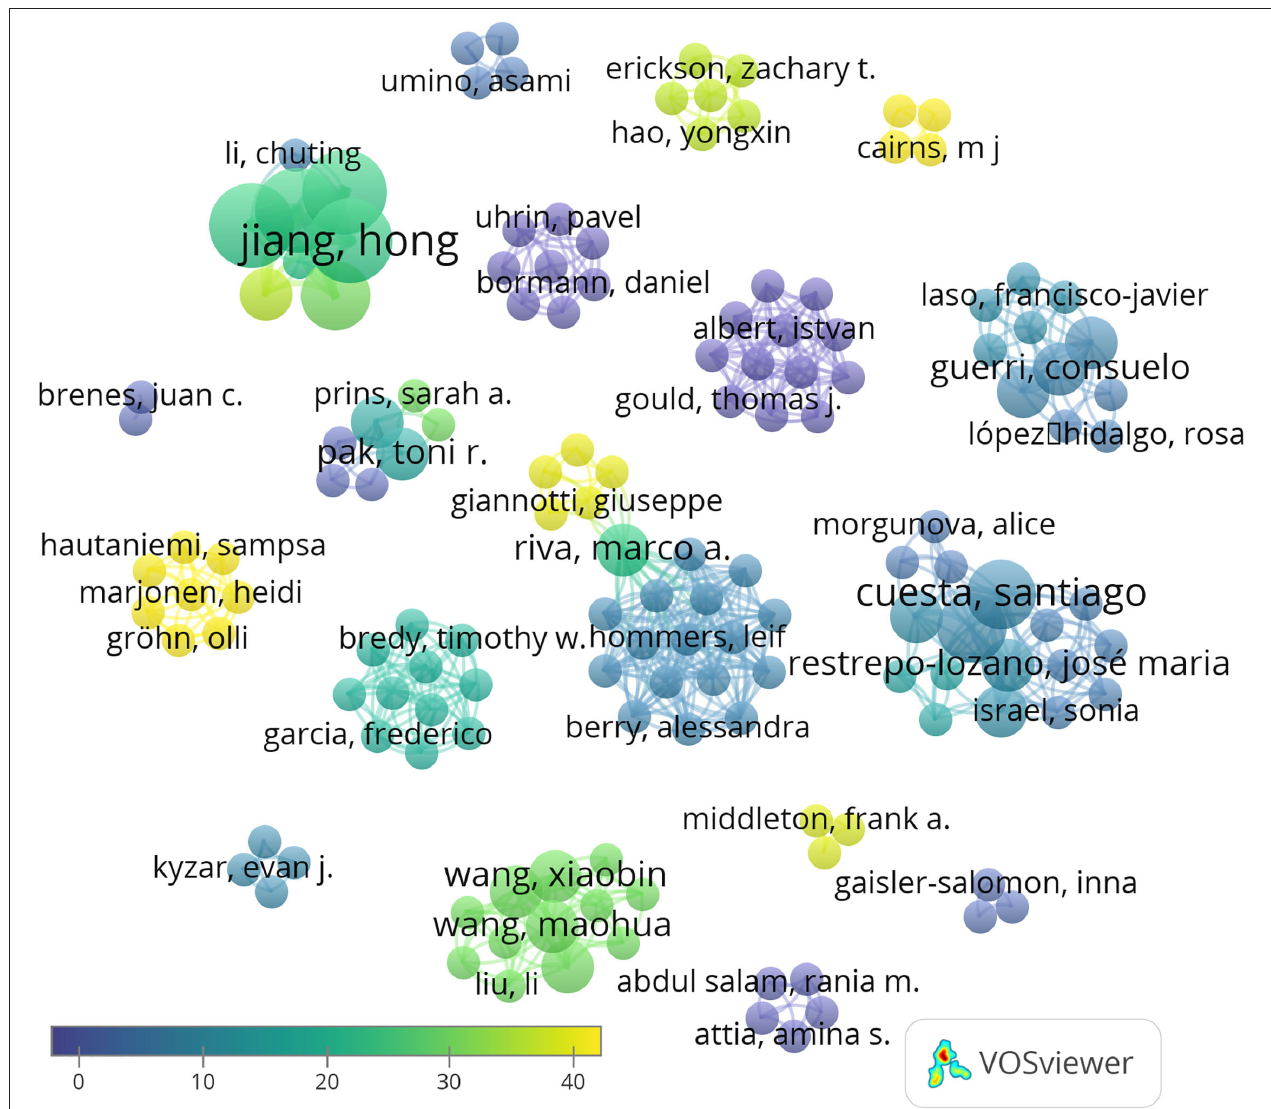
FIGURE 3 | Network data map of the articles’ authorship indicating research groups and collaborations. Collaboration between only two groups its shown in the center of the figure. Some representative authors of each research team are highlighted. Point size represents the number of published articles. Colors show the average citations, and lines show clusters based on